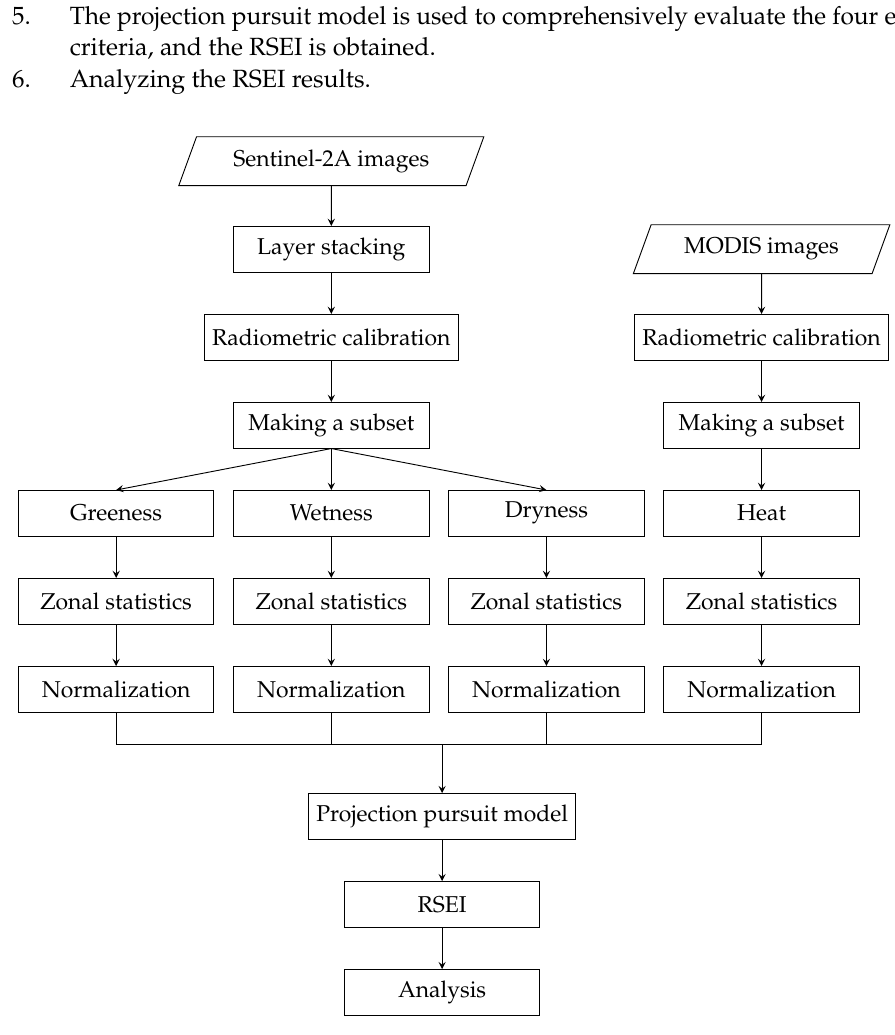
Figure 5. Technical